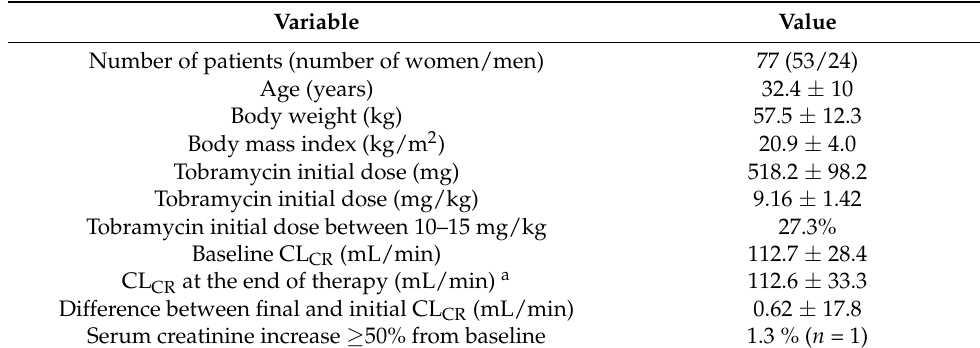
Table 1. Patient characteristics.